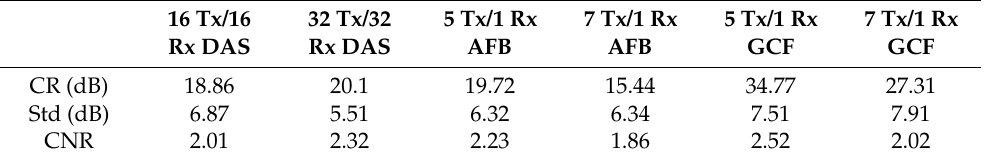
Table 4. Contrast (CR), standard deviation (STD), and contrast-to-noise ratio (CNR) of the images acquired using six methods, as shown in Figure